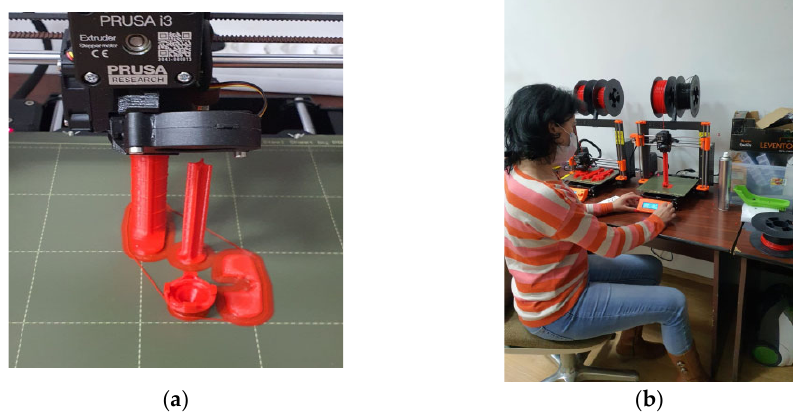
Figure 3. The physical achievement of this dispenser: ( a ) Prusa I3 MK3S+ Printer and ( b ) adjusting the printer parameters.